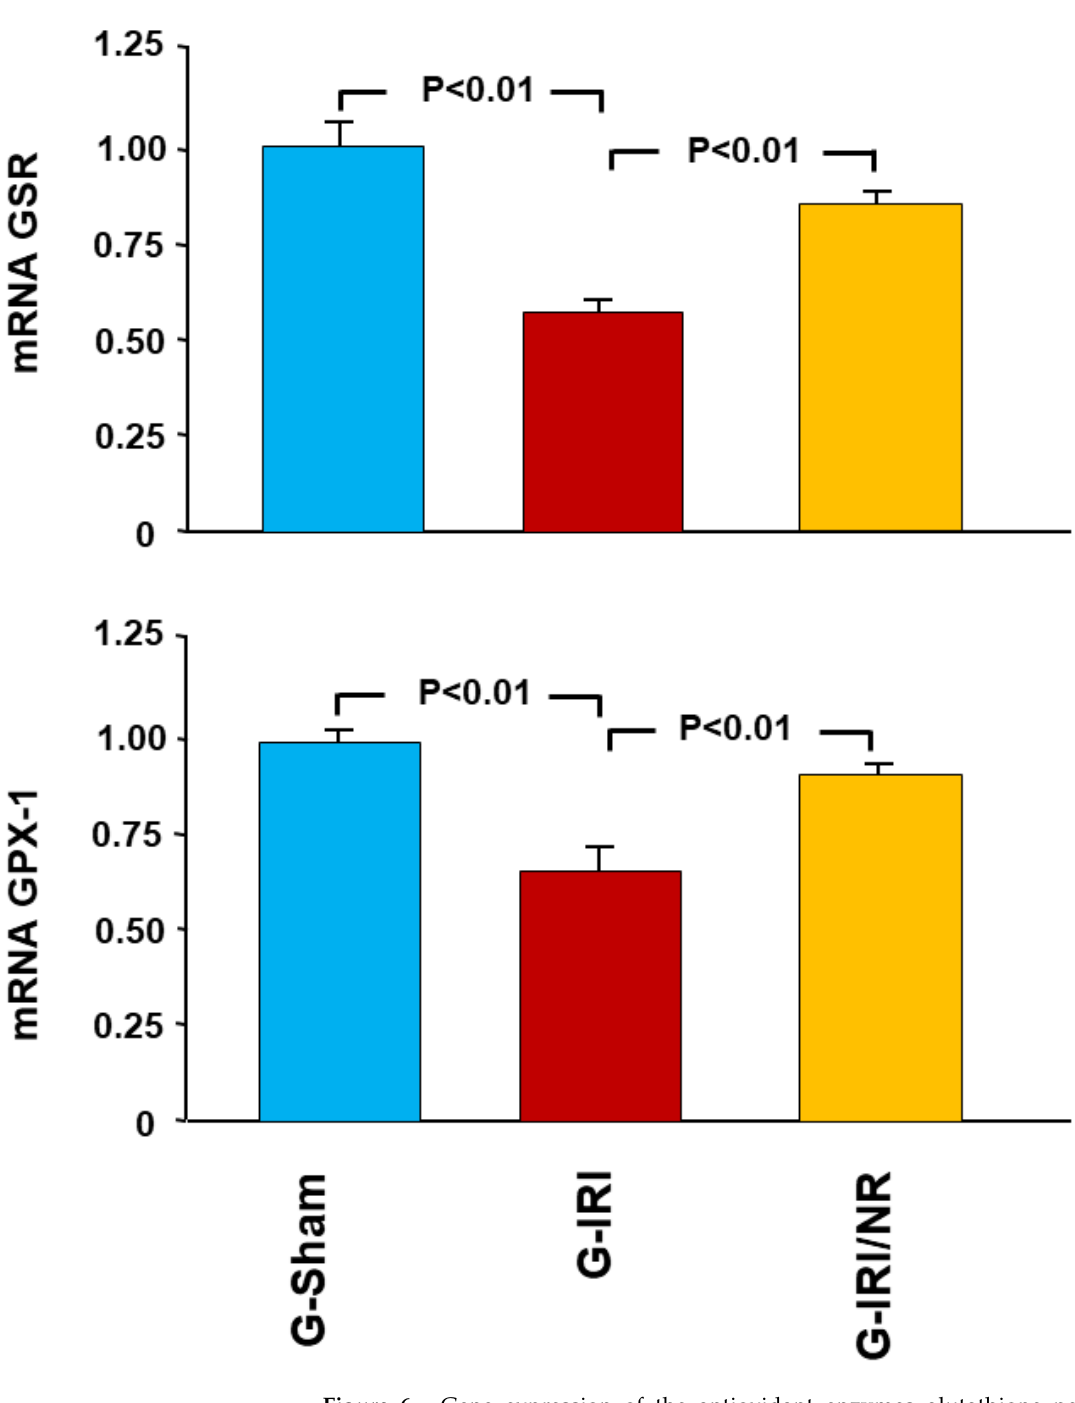
Figure 6. Gene expression of the antioxidant enzymes glutathione peroxidase (GPX-1) and glutathione-disulfide reductase (GSR) in all groups. Values represent mean ± SEM.